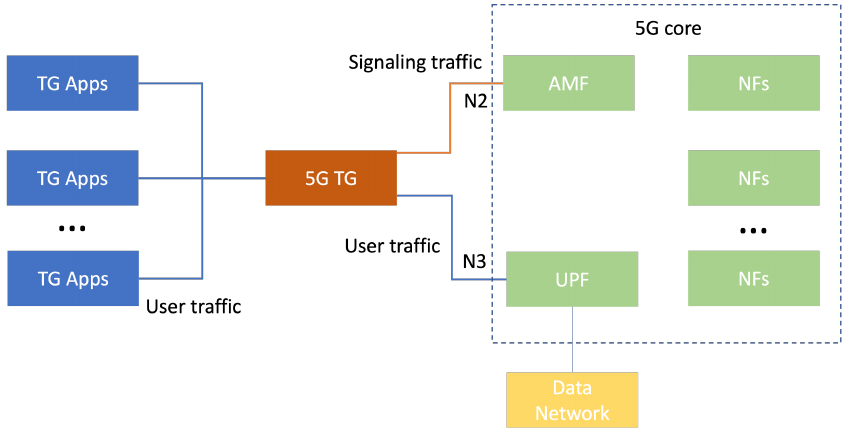
Figure 3. 5G traffic generation architecture.